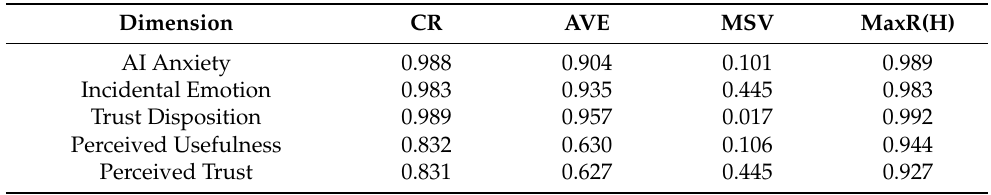
Table 5. Model validity measures.